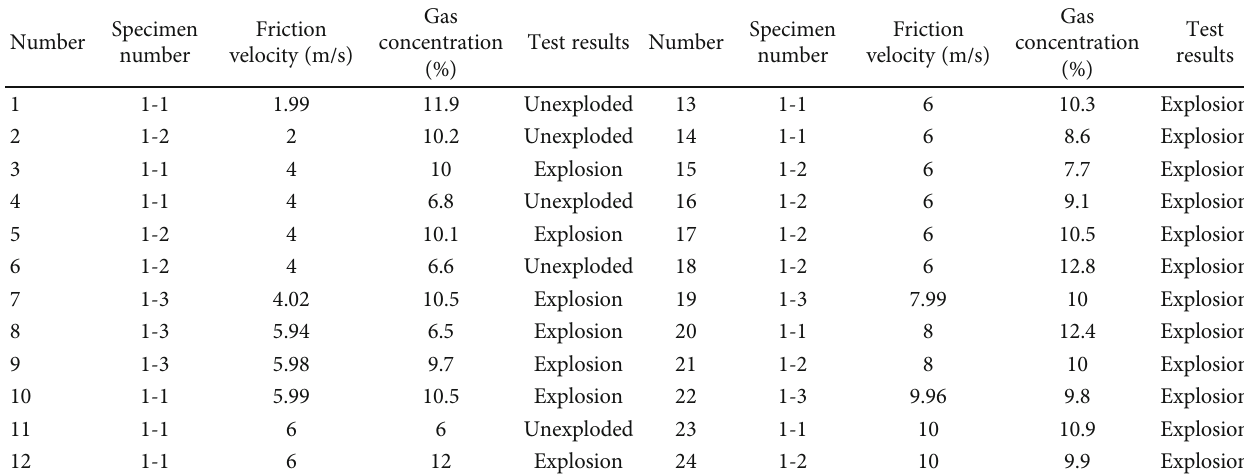
Table 2: Gas ignition results of hard sandstone friction